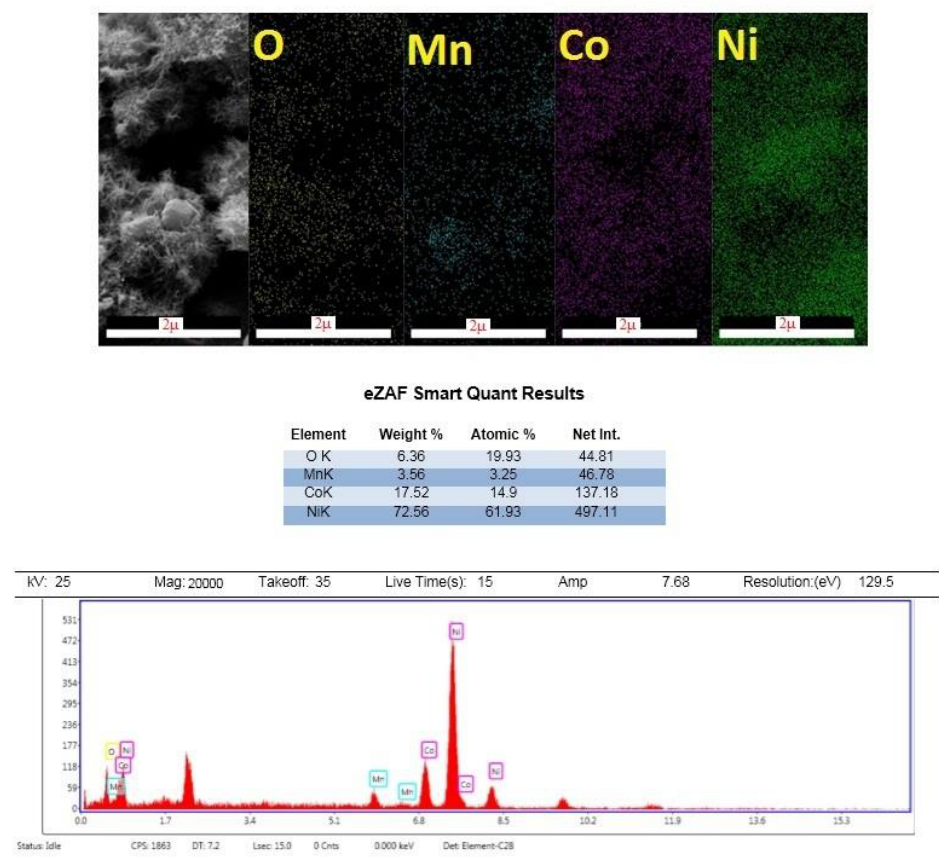
Figure 3. EDX mapping analysis of MnCo 2 O 4 /NiCo 2 O 4 .